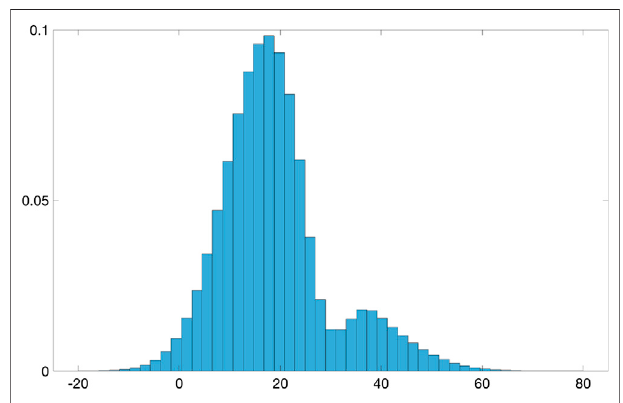
FIGURE 6 | Prior marginal distribution of the initial temperature fi eld for the selection Kalman model.